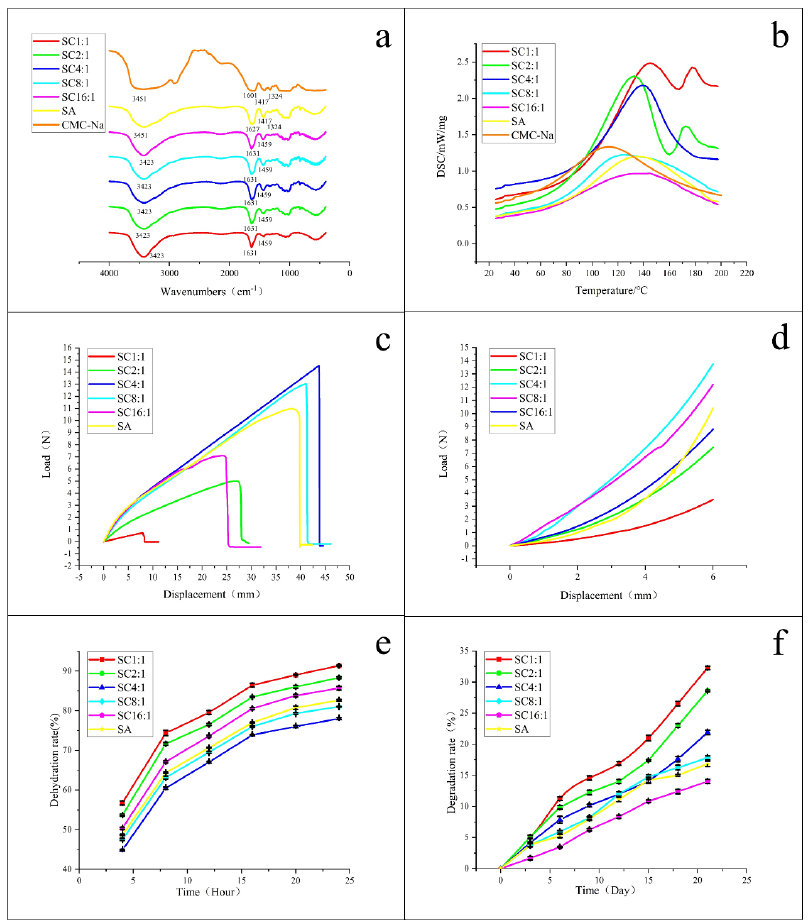
Figure 3. ( a ) FT-IR and ( b ) DSC curves of SC composite hydrogels; ( c ) tensile performance and ( d ) compression stress of support when compression deformation was 60% of SC composite scaffolds with different mass ratios; ( e ) solution viscosity test and ( f ) in vitro degradation rate of SC composite scaffolds with different mass ratios (each value represents the mean ± S.D. ( n = 3)). All of these mentioned above indicate that SA and CMC-Na were compatible when the composition ratio of SA/CMC-Na was at 4:1–16:1. This conclusion can also be reflected and verified by the DSC curves in Figure 3b, from which we can see that there were two melting point peaks in the DSC curves of SC1:1 and SC2:1 and only one melting point peak in the DSC curves of SC4:1, SC8:1, and SC16:1. One melting peak indicates a good miscibility, while more than one melting point peak indicates the immiscibility or partial miscibility or immiscibility of different polymers. That is to say, for the blend hydrogels of SC1:1 and SC2:1, the components in hydrogels were incompatible or partially incom- patible, and for the blend hydrogels of SC4:1, SC8:1, and SC16:1, the components in hy- drogels were compatible. This conclusion shows a good agreement with the morphology and FTIR analysis results. 3.1.3. Mechanical Properties of Blend Hydrogel Scaffolds The mechanical properties of SC blend hydrogel scaffolds are shown in Figure 3c,d. The calculated maximum load and the fracture stress are given in Table 1. By comparing